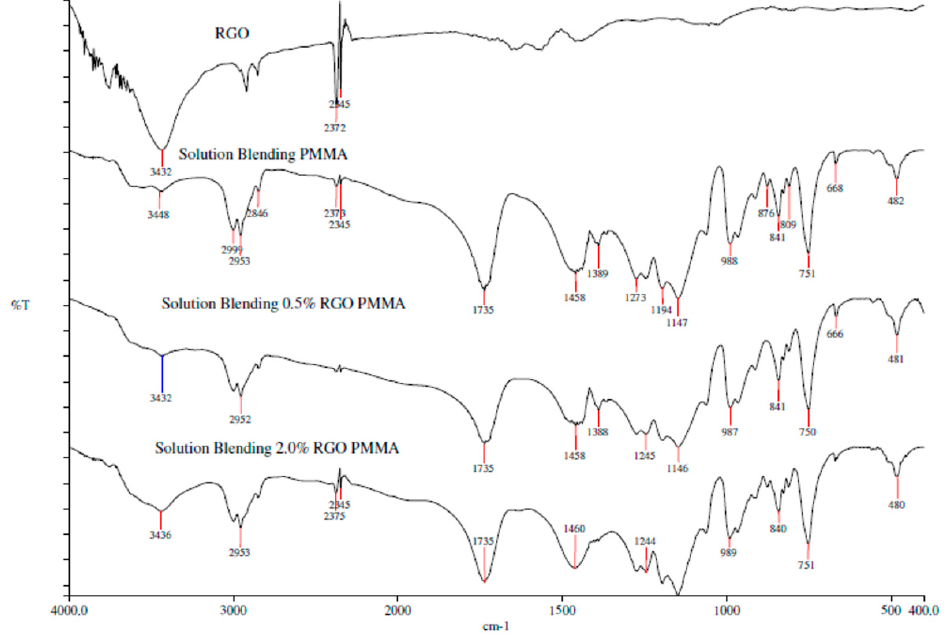
Figure 7. FTIR spectra of RGO, PMMA and nanocomposites prepared by solution blending.